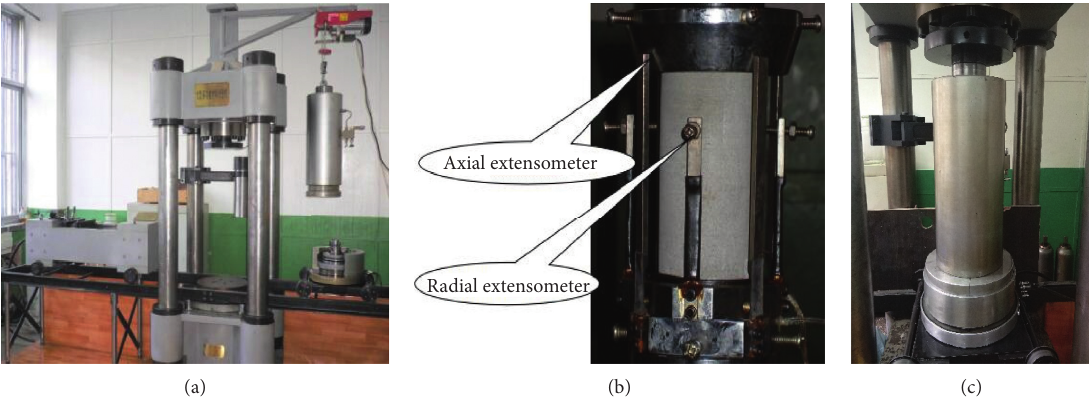
Figure 1: The WDT-1500 multi-function material testing machine, extensometer diagram, pressure chamber diagram. (a) Testing machine. (b) Extensometer diagram. (c) Pressure chamber diagram.